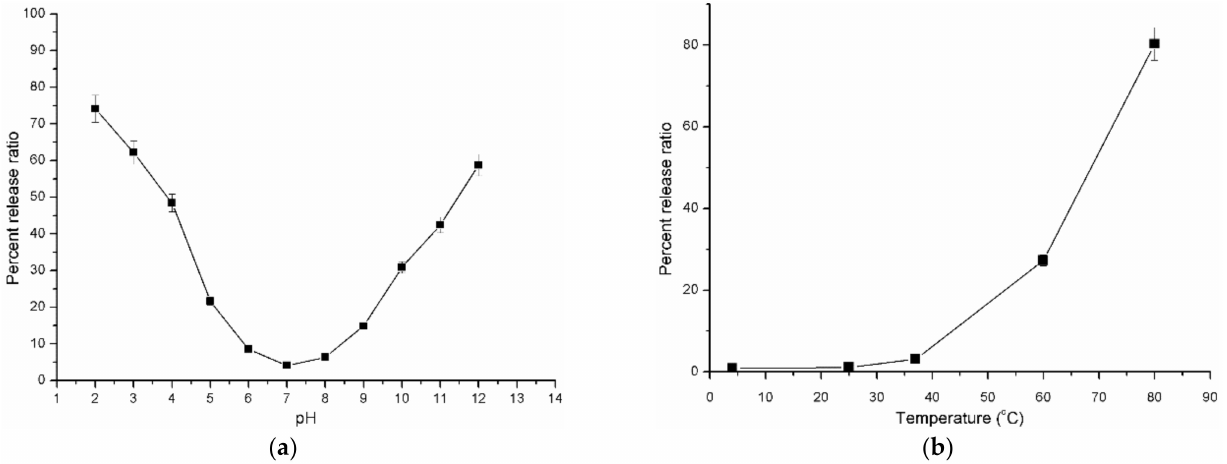
Figure 5. ( a ) Influence of pH on the percent release ratio of nanoliposomes; ( b ) effect of temperature on the drug release ratio of